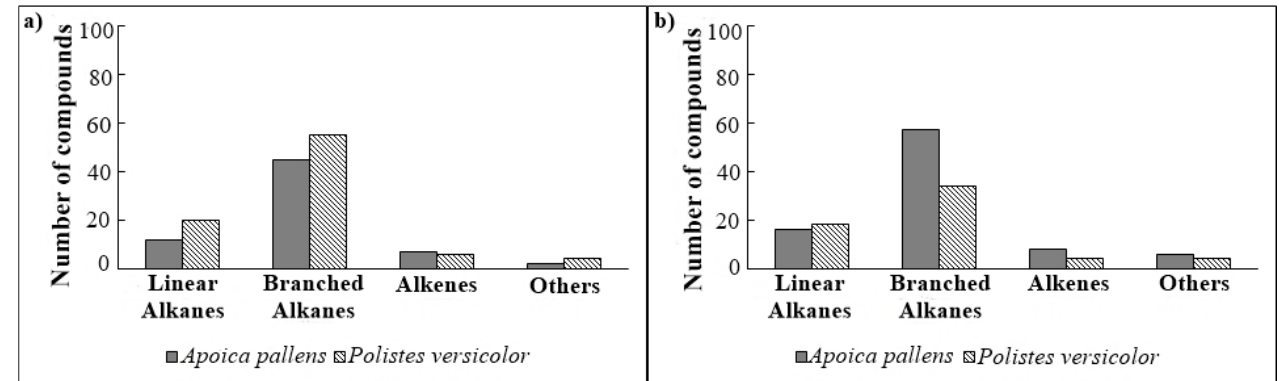
Fig 1 . Mean percentage of different classes of compounds in a) cuticular chemical profile and b) venom chemical profile of Apoica pallens and Polistes versicolor .